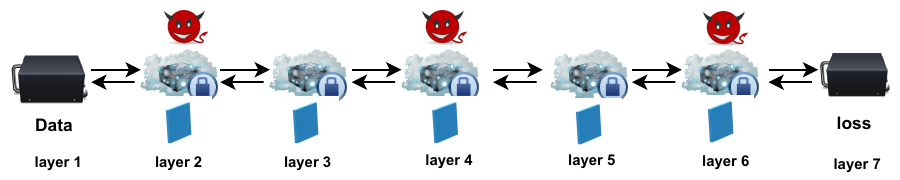
Figure 4. The most severe attack in the second case in